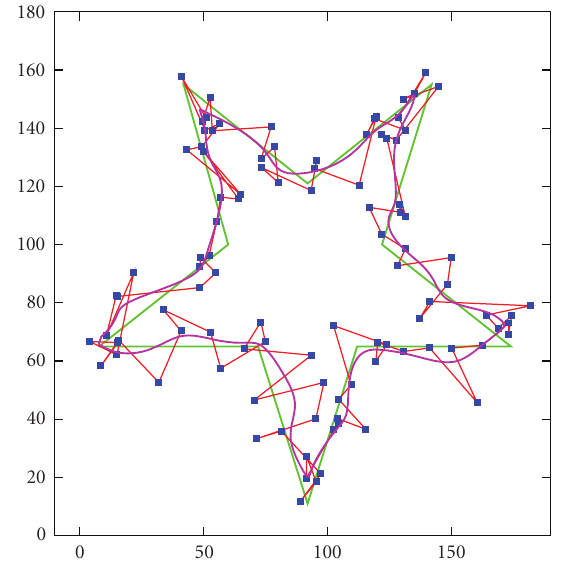
Figure 5: Recovery of the boundary of the star specified by 100 points with Gaussian noise of ν = 8 as in Figure 4. The recovered curve is shown as a thicker